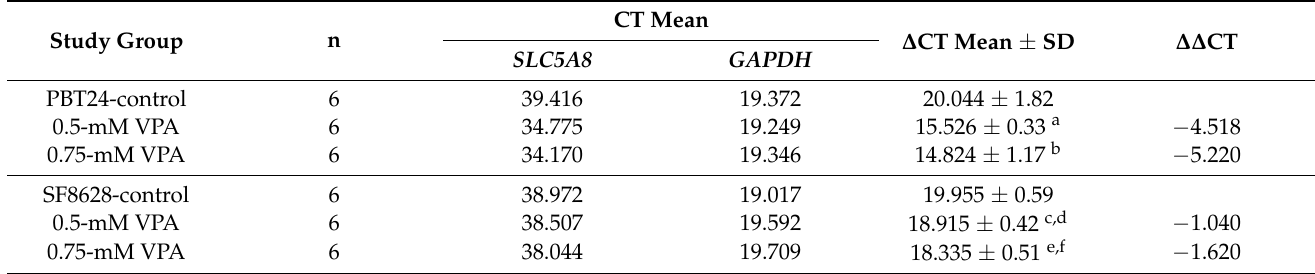
Table 3. RNA expression of SLC5A8 in PBT24 and SF8628 cell study groups.